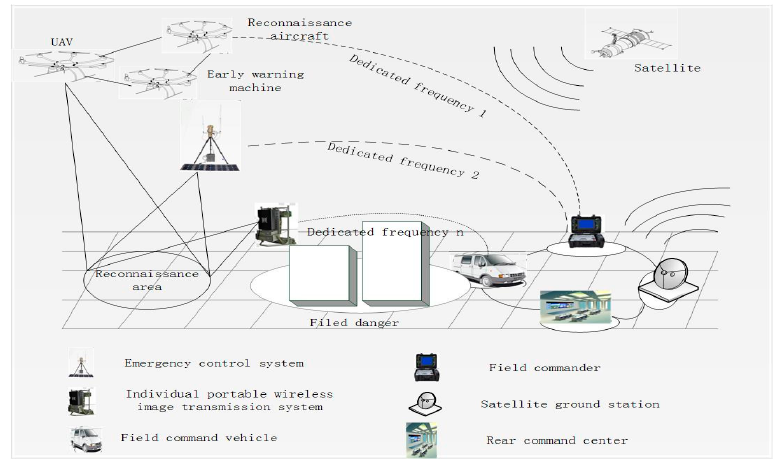
Figure 1. Information Transmission Diagram.